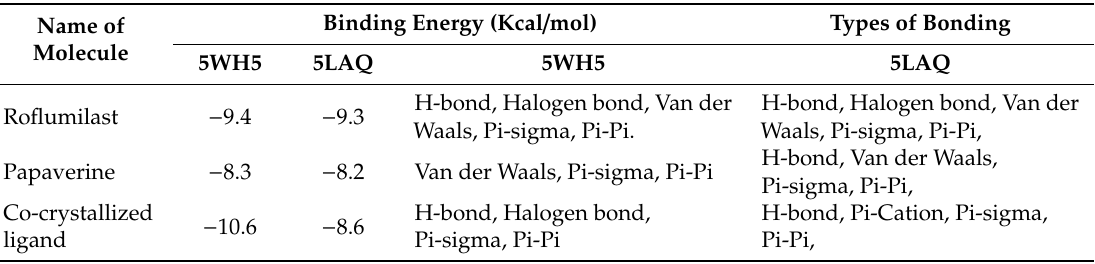
Table 2. Molecular docking scores with PDE-4B (5WH5) and PDE-4D (5LAQ)